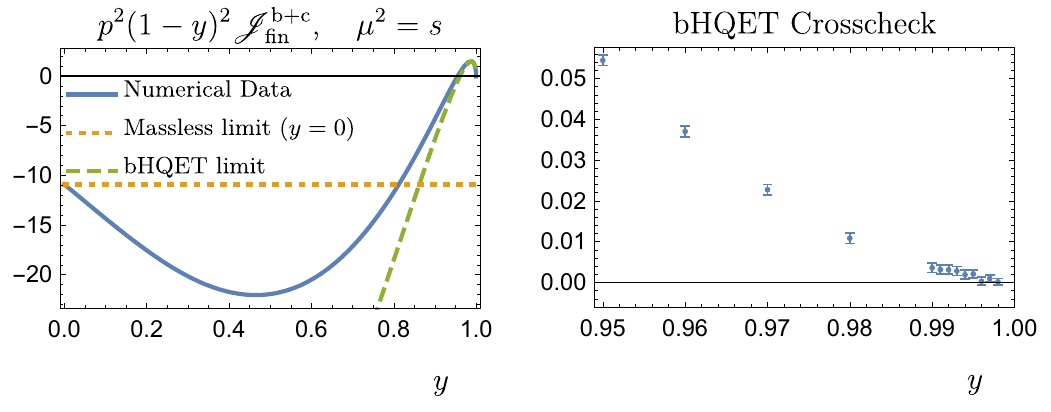
Figure 4 . Left: Contribution of diagrams (b) and (c) to the jet-function ME (cid:12)nite part multiplied with the singularity-damping factor p 2 (1 (cid:0) y ) 2 as a function of y (cid:17) m 2 =p 2 for (cid:22) 2 = s . The numerical data from pySecDec is shown as the solid blue line. The associated numerical uncertainty is too small to be visible in the plot. The corresponding heavy quark (bHQET) limit, according to eq. (5.21), is shown as dashed green line. The dotted orange line represents the value of the jet-function ME times damping factor in the massless limit ( y = 0), i.e. to the L 0 ( p 2 ) term in eq. (5.20). Right: Di(cid:11)erence between numerical data points and analytic bHQET limit, normalized to the massless limit, for (cid:22) 2 = s . The error bars indicate the uncertainty of the numerical integration using pySecDec . two-loop bHQET jet function J ( n ‘ )